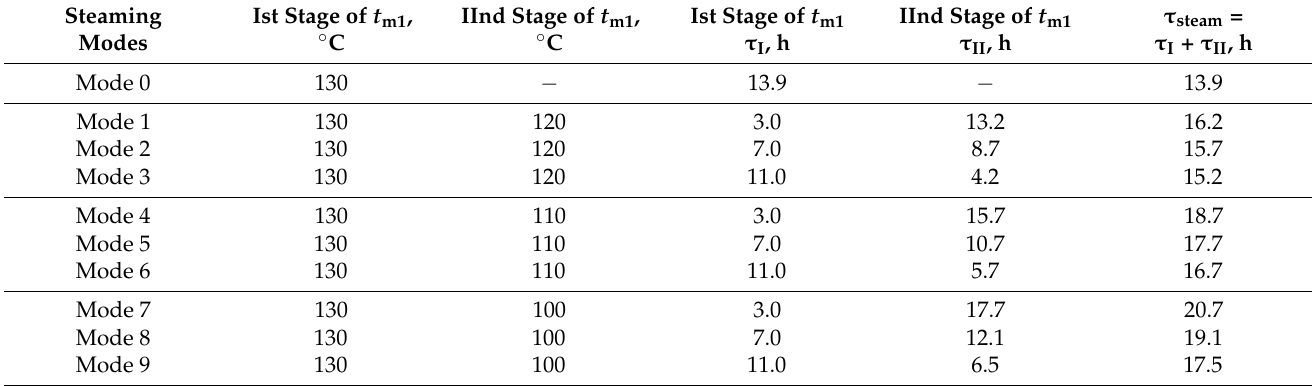
Table 1. Change in the temperature t m1 and duration τ steam of the studied autoclave steaming modes.